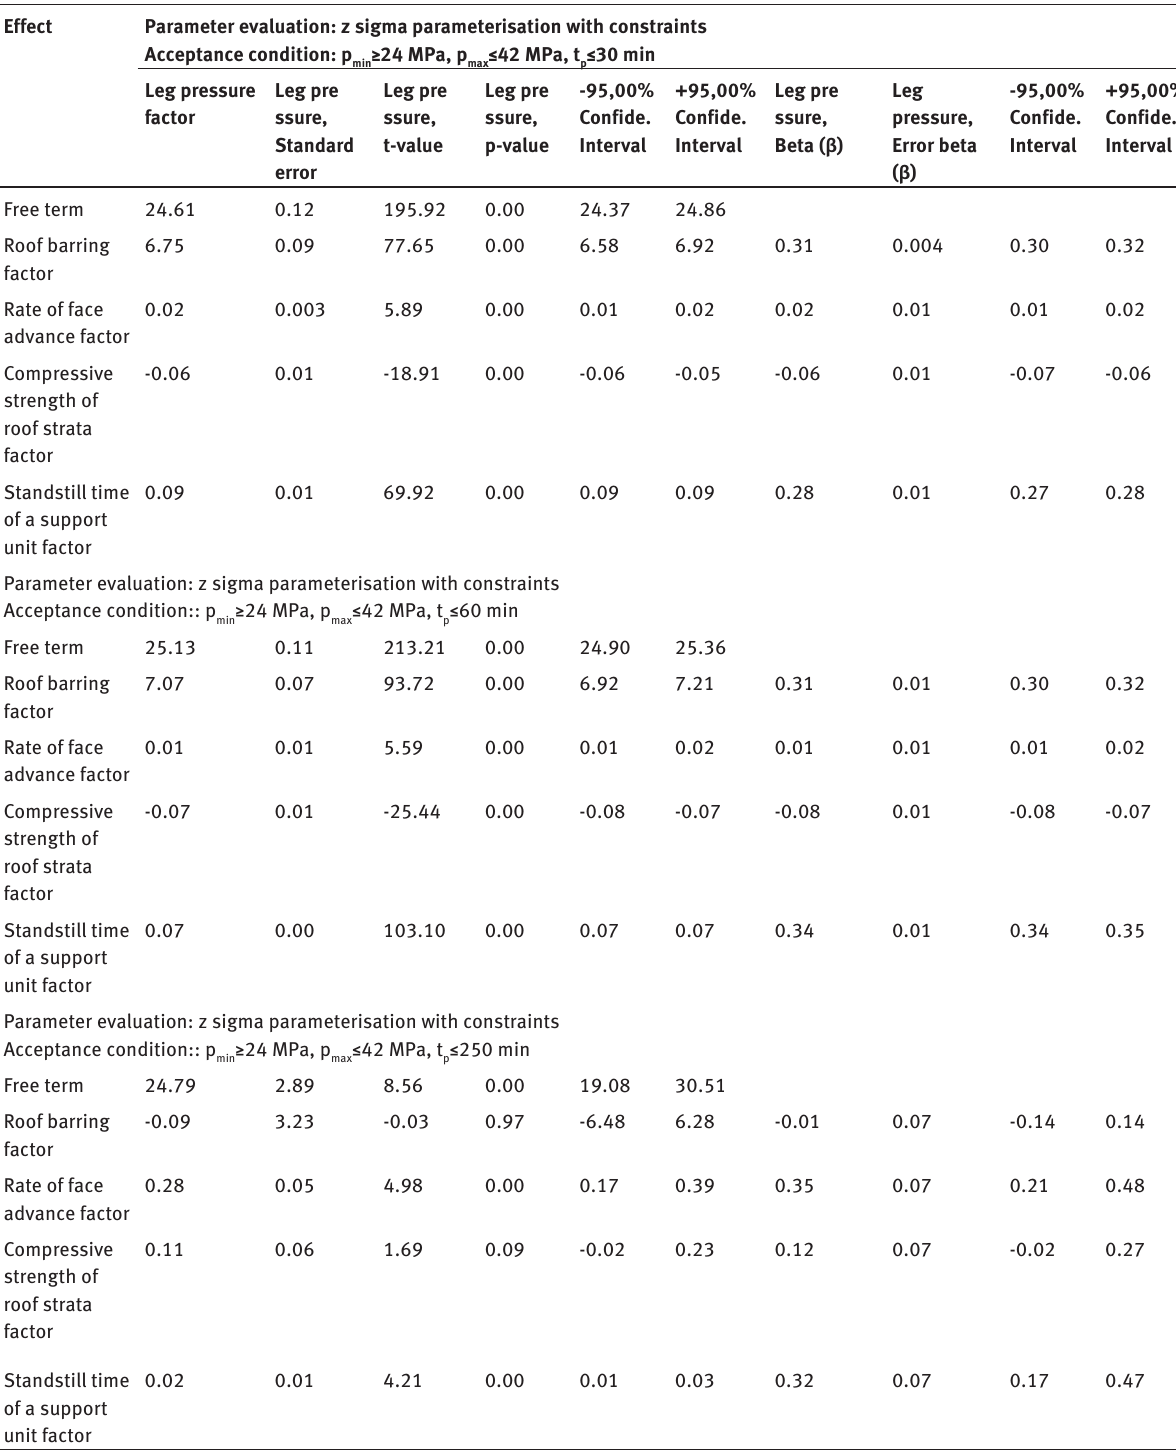
Table 3: Statistical significance of model parameters.